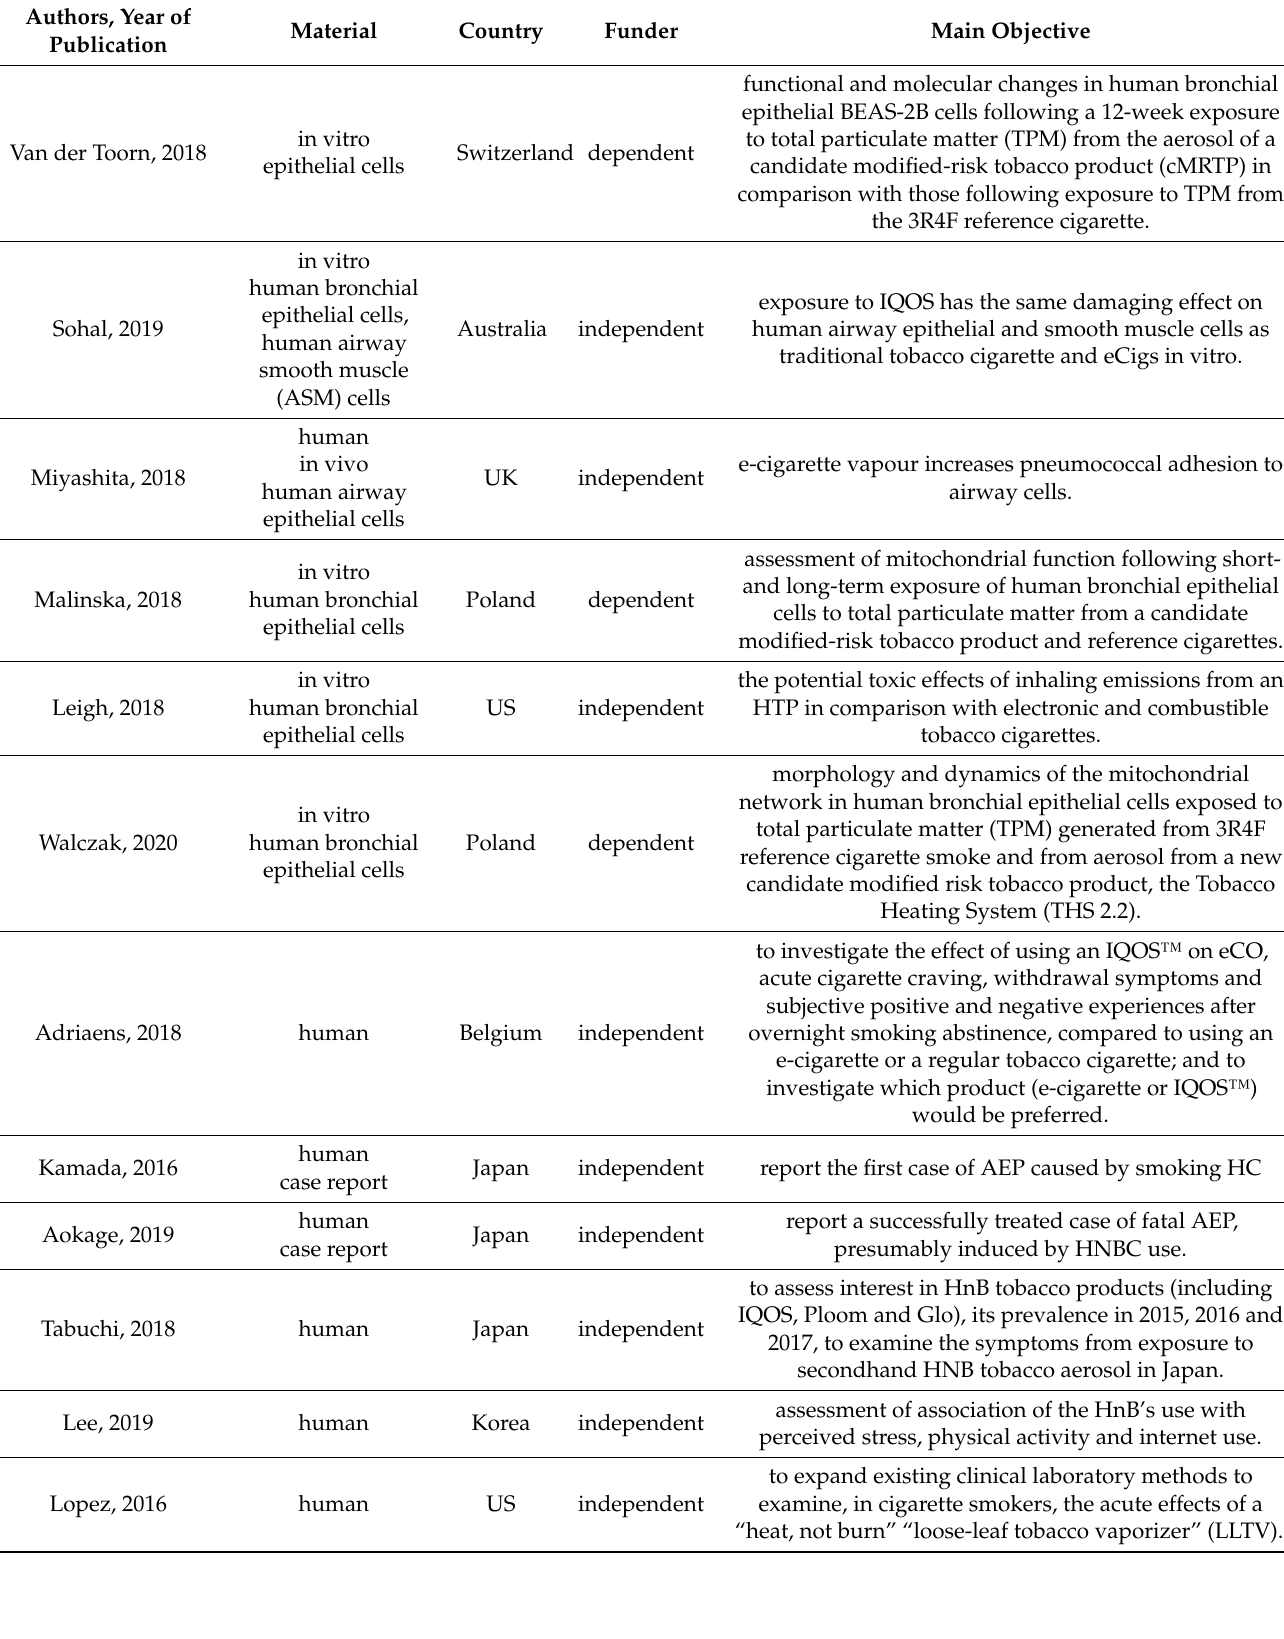
Table 1. Studies included in the